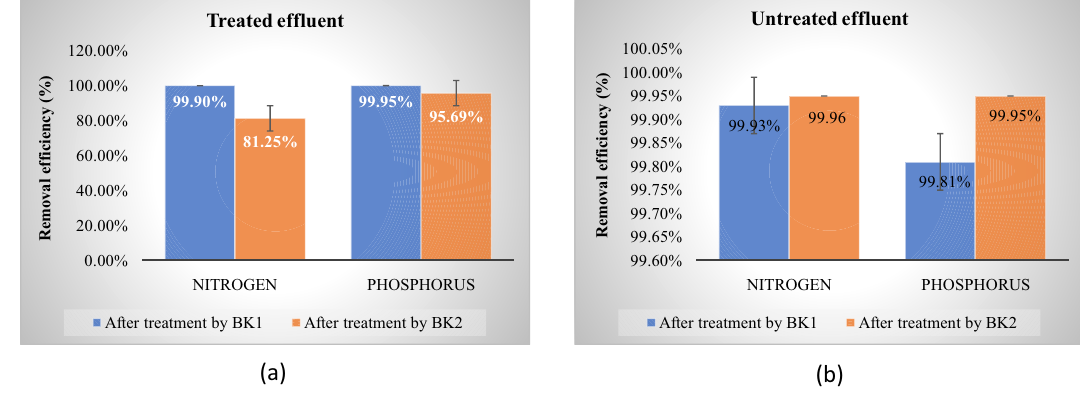
Figure 2. Removal of nitrogen and phosphorus (%) by BK1 and BK2.